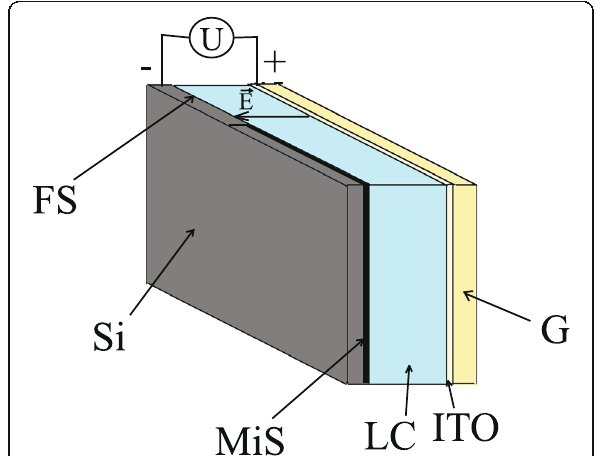
Fig. 1 Structure of a hybrid LC cell: silicon substrate ( Si ); microstructured silicon surface ( MiS ); flat silicon surface ( FS ); liquid crystals ( LC ); glass substrate ( G ); ITO electrode ( ITO ); applied voltage ( U ); electric field ! vector ( E